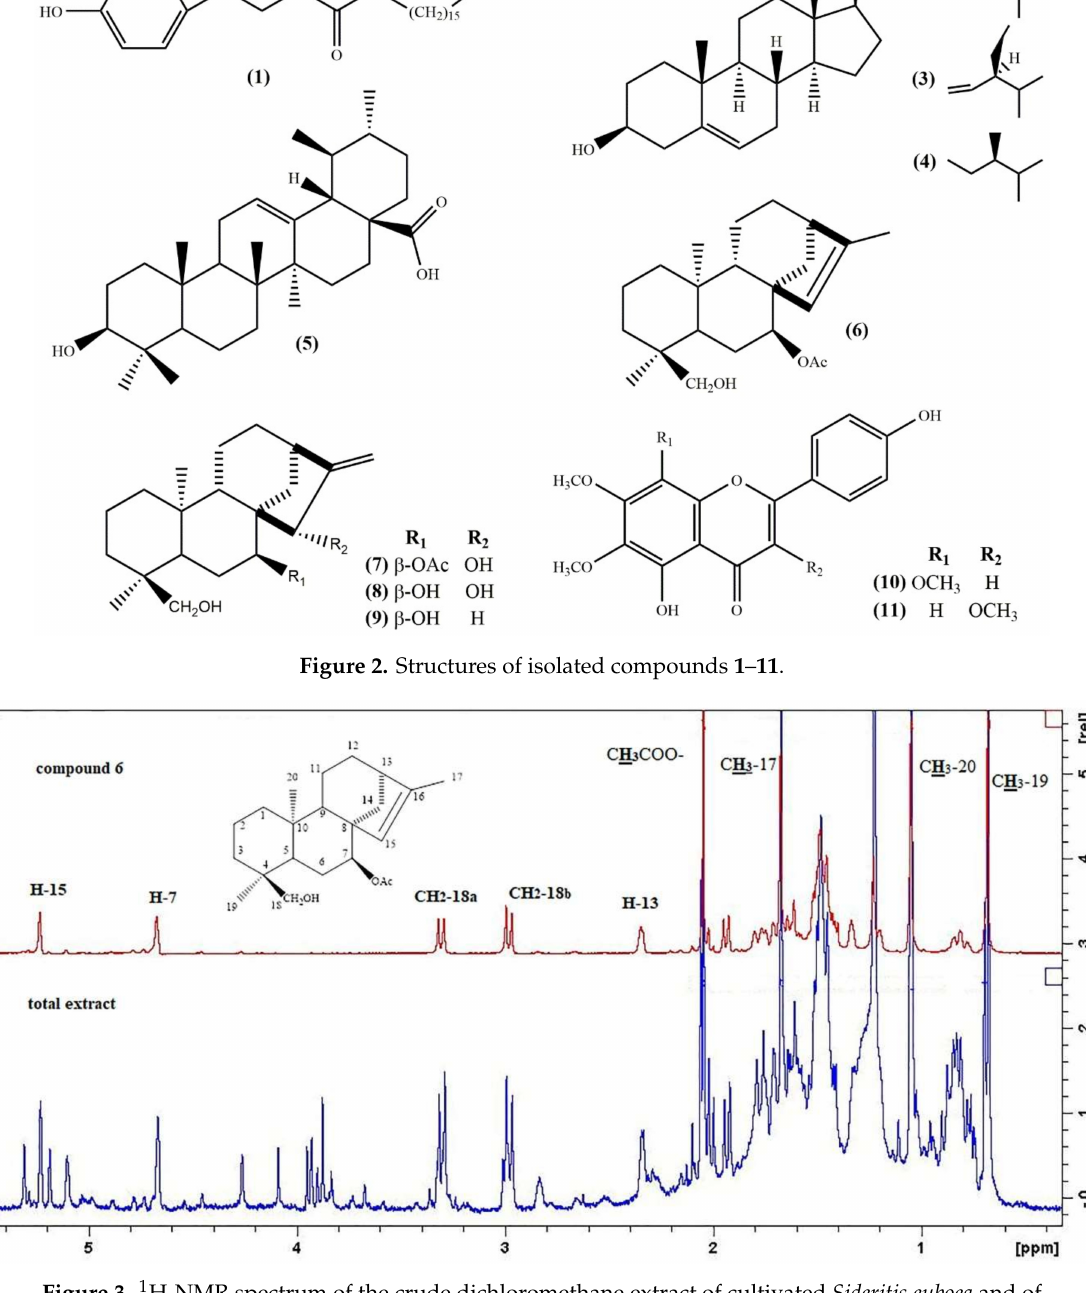
Figure 3. 1 H-NMR spectrum of the crude dichloromethane extract of cultivated Sideritis euboea and of the isolated compound 6 from the same